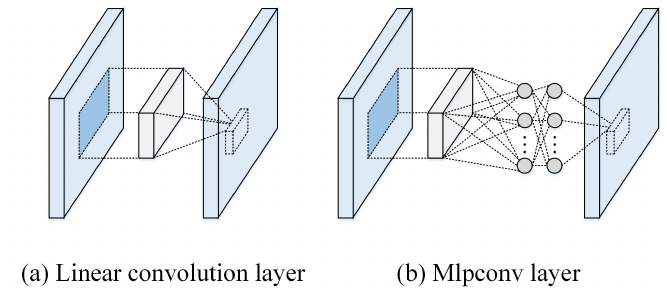
Figure 10. Comparison of linear convolution layer and mlpconv